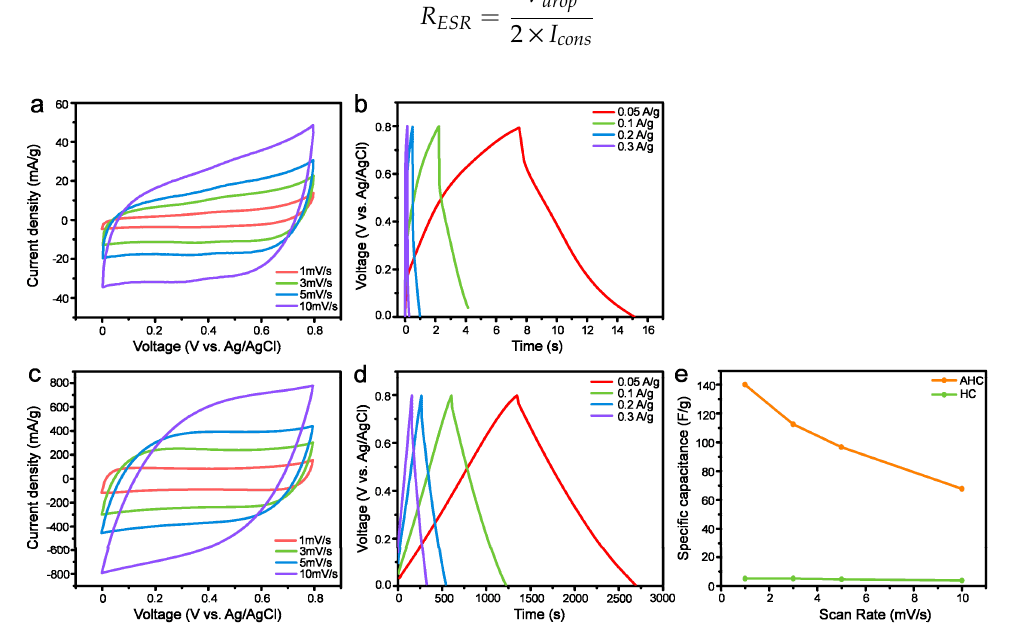
Figure 5. ( a ) CVs of HC electrode from 1 to 10 mV s − 1 . ( b ) Charge–discharge curves of HC electrode from 0.05 to 0.3 A g − 1 . ( c ) CVs of AHC electrode from 1 to 10 mV s − 1 . ( d ) CD graphs of AHC electrode from 0.05 A g − 1 to 0.3 A g − 1 . ( e ) Specific capacitance of AHC and HC from the galvanostatic discharge curves at different scan rates.